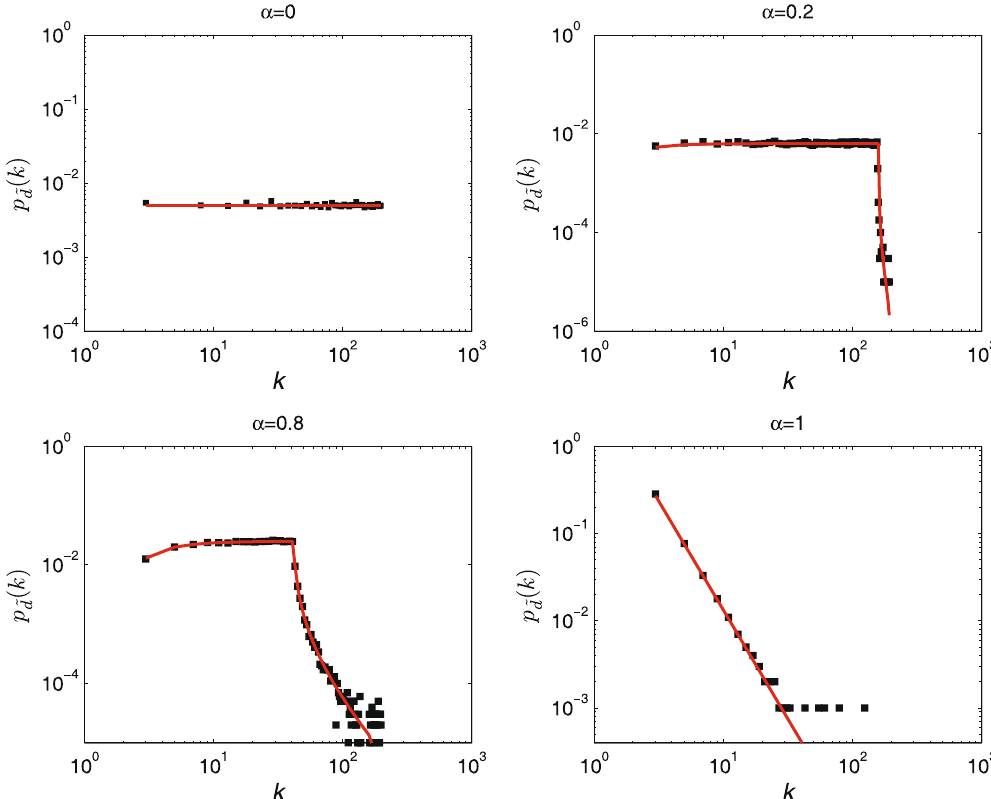
Figure 2. The displayed degree distribution (in a log-log scale) for various attack information perfection parameter α in a random scale-free network. The degree distribution follows p d ( k ) = ( λ − 1) m λ − 1 k − λ , where N = 1000, λ = 2.5 and m = 2. The simulation results are averaged over 100 independent realizations of imperfect attack information. The solid lines correspond to the analytical results (see